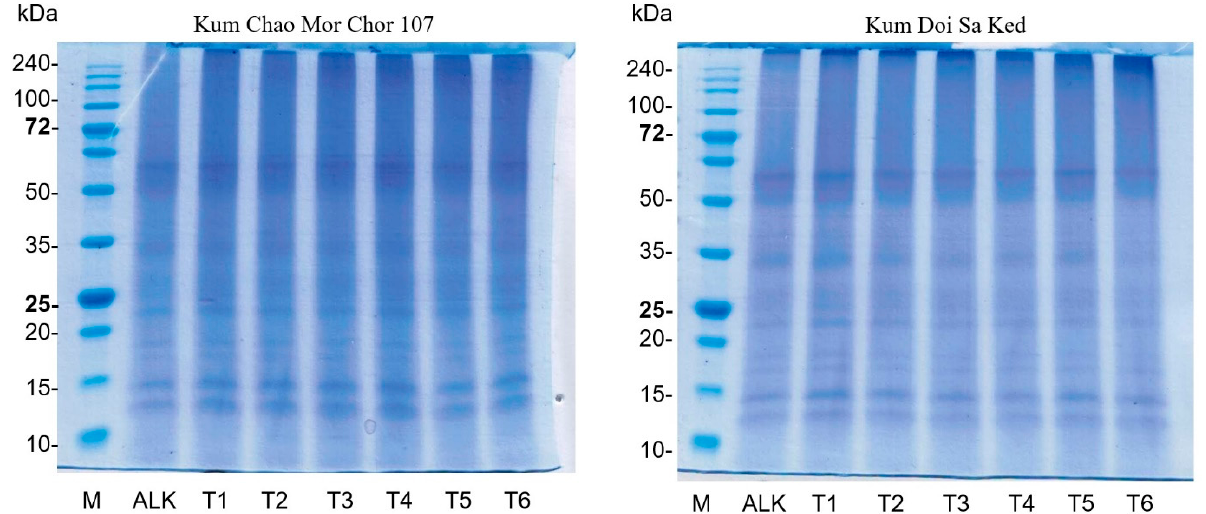
Figure Figure 2. Patterns of rice bran proteins derived from ALK and different PEF treatments (T1: 2.3 kV/cm + 15 min; T2: 2.3 kV/cm + 20 min; T3: 2.3 kV/cm + 25 min; T4: 1.3 kV/cm + 15 min; T5: 1.3 kV/cm + 20 min; T6: 1.3 kV/cm + 25 min).